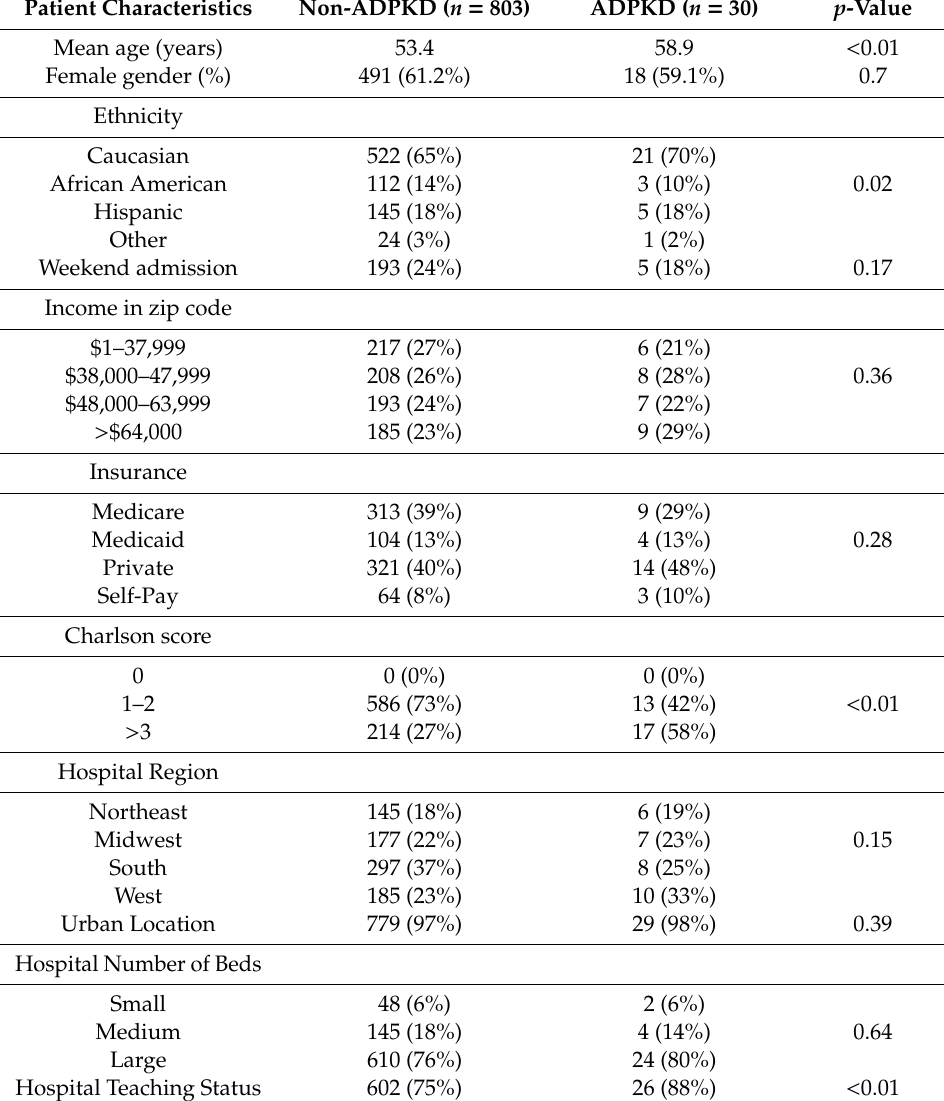
Table 1. Patient and hospital